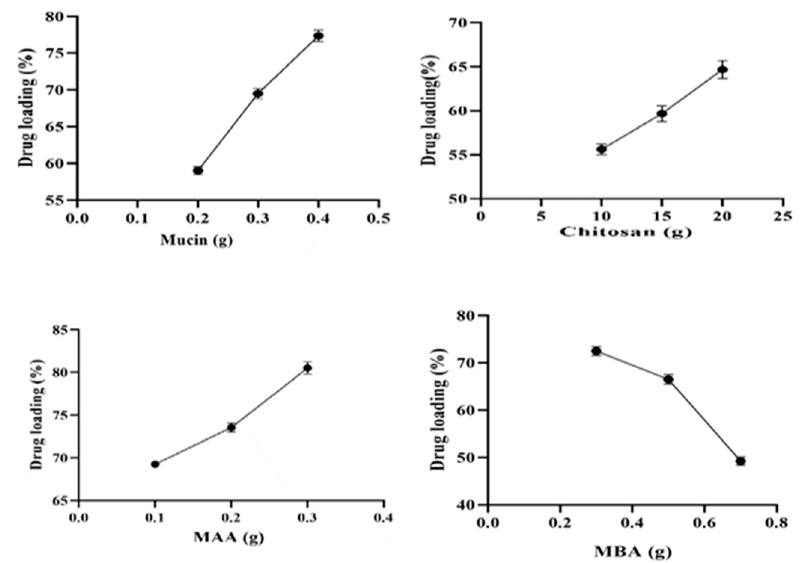
Figure 7. Effect of mucin, chitosan, MAA, and MBA on Tofacitinib loading.